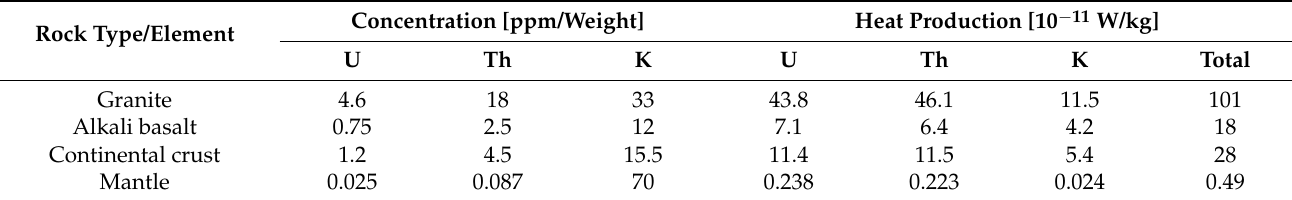
Table 1. Estimates of radioactive heat production in the selected rocks [after